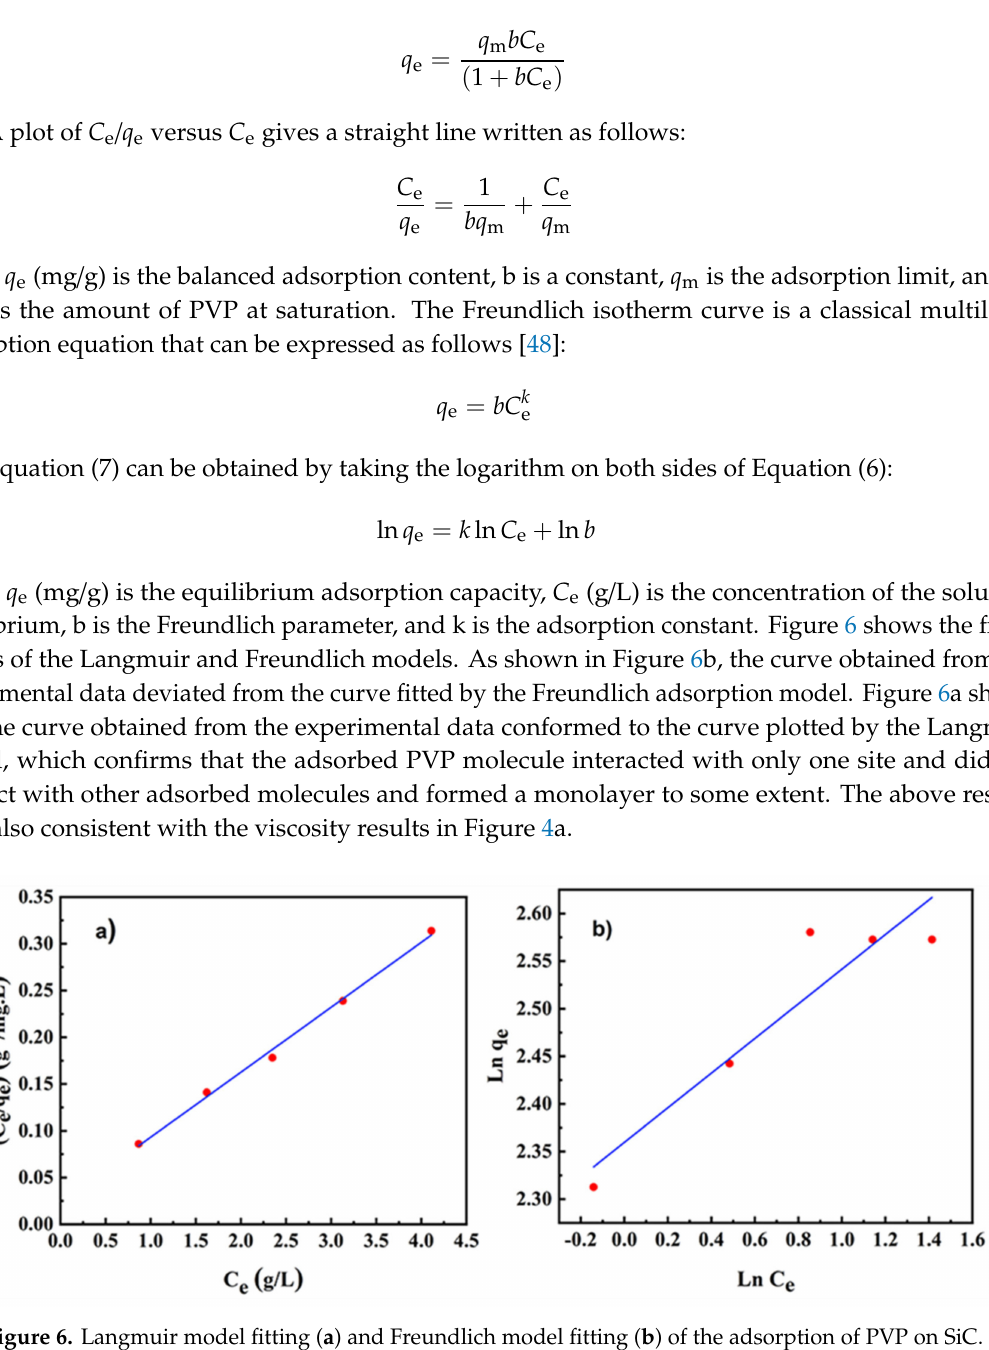
Figure 6. Langmuir model fitting ( a ) and Freundlich model fitting ( b ) of the adsorption of PVP on